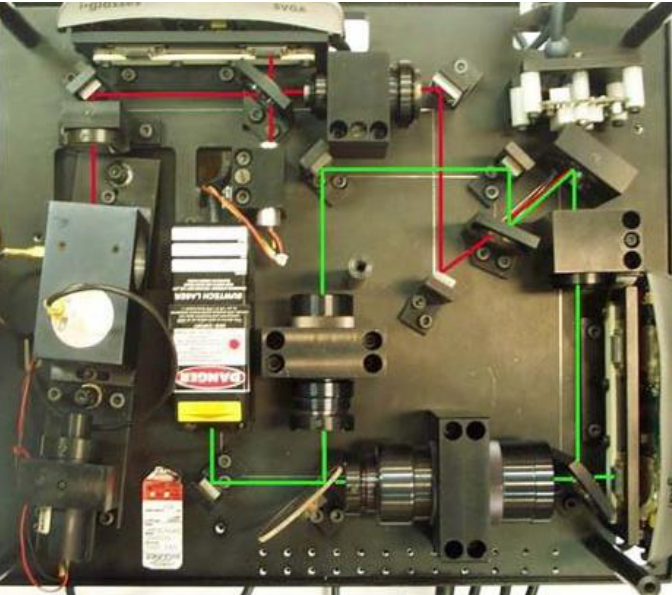
Figure 3. POAC computer [59]. In the picture, a laptop hardware version of the programmable optical analogic array computer (POAC) is shown, which provides high computing speed and full parallelism, having a large input array and template array size.